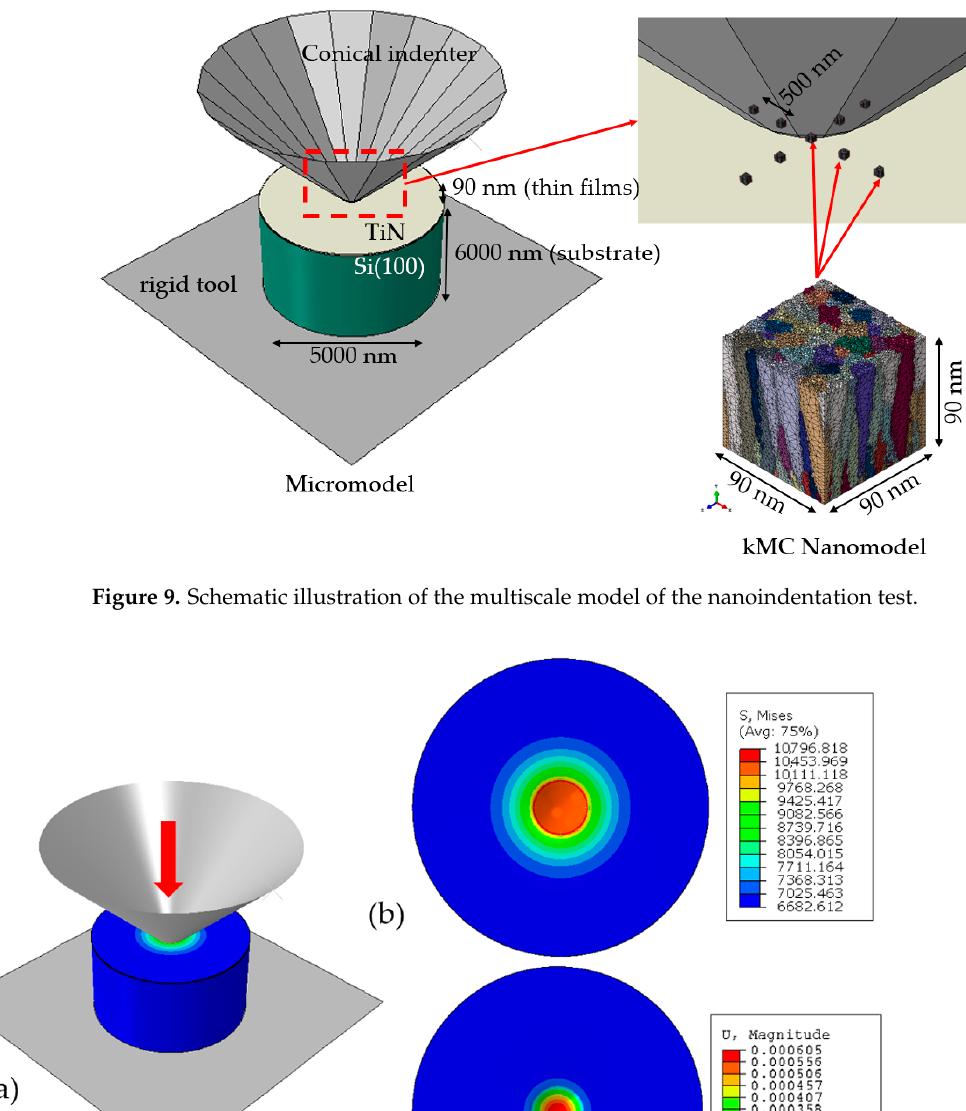
Figure 9. Schematic illustration of the multiscale model of the nanoindentation test.